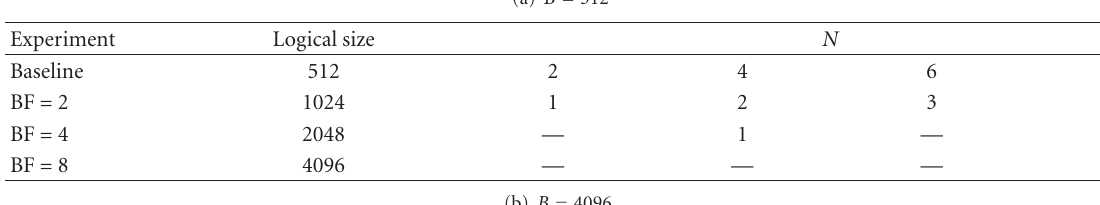
Table 2: Summary of experiments for evaluating enhanced algorithm.